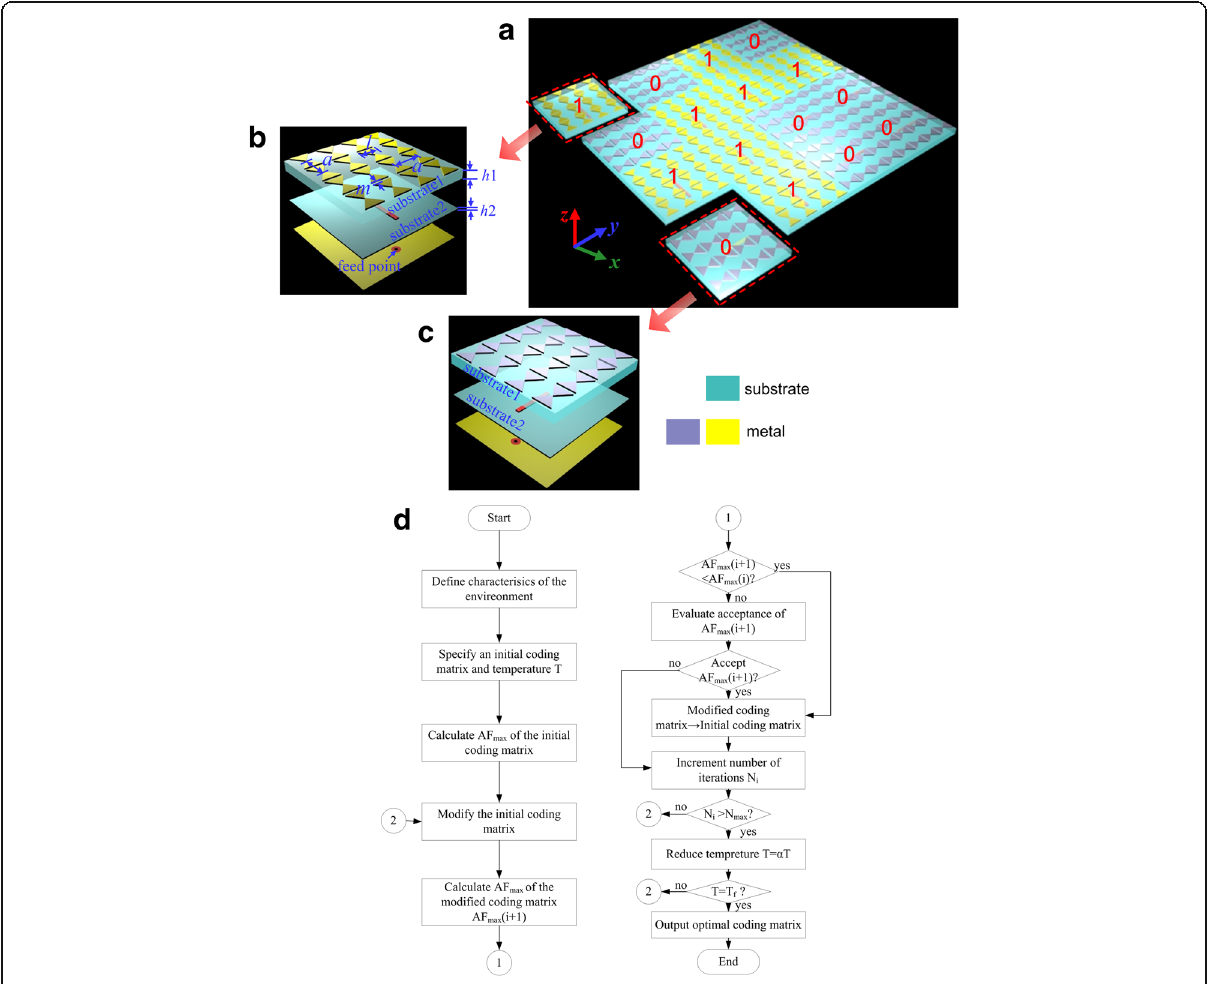
Fig. 1 Coding EMMS and its constituent anisotropic element. a Coding EMMS consists of 4 × 4 pieces of anisotropic elements. The numbers of “ 0 ” and “ 1 ” elements are the same. Schematic geometry of the anisotropic “ 1 ” element ( b ) and “ 0 ” element ( c ) ( a = 9 mm, l = 6 mm, m = 1 mm, h 1 = 3 mm, h 2 = 0.5 mm). d Flowchart of the SAA for finding the optimal coding